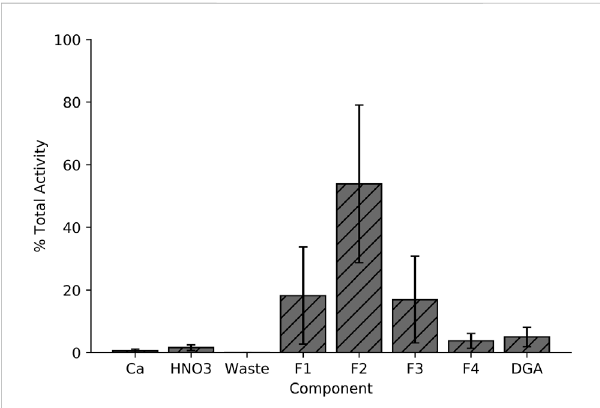
FIGURE 7 Elutionpro fi lefortheCa +2 /Sc +3 radiochemicalseparationusedin this work. Activity distribution in each of the 4 eluted fractions varies with each experiment, but the overall eluted fraction remains